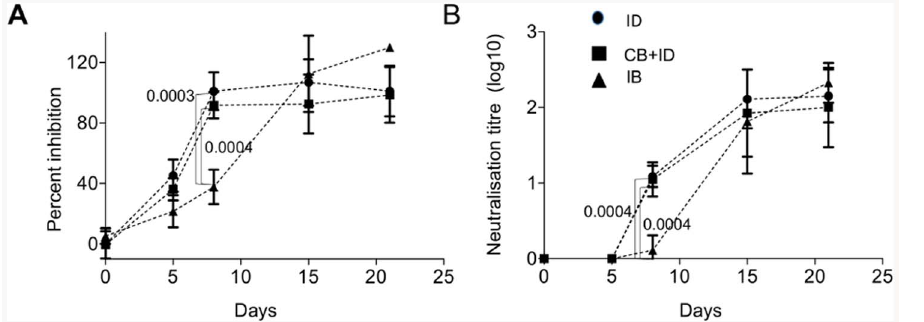
Figure 5. Anti-VP7 and neutralizing antibody response in serum is delayed in C.nubeculosous- infected sheep. A. Anti-VP7 antibodies were detected by competitive ELISA at 0, 5, 8, 15 and 21 dpi. B. Neutralizing antibodies were assessed at 0, 5, 8, 15 and 21 dpi in BHK21 cells by serum neutralization with 50 TCID 50 BTV8 (triplicates per sheep and per day). Statistical differences between groups were calculated by a Mann- Whitney U test on each day and the p values are reported for day